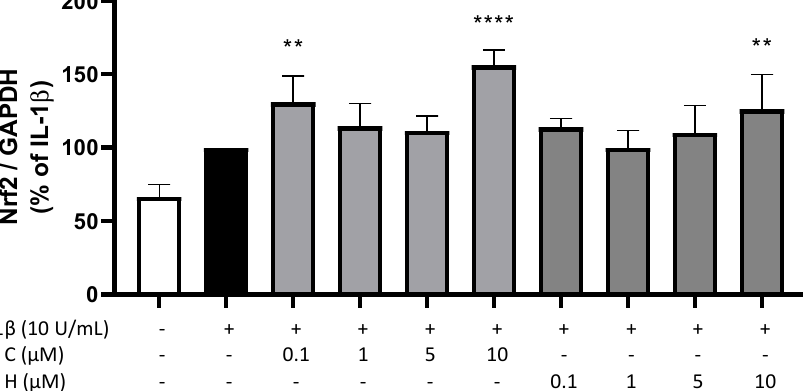
Figure 6. Effects of KIT C (light grey) and KIT H (dark grey) on Nrf-2 expression in IL-1 β -stimulated SK-N-SH cells. SK-cells were stimulated as described in material and methods. After 4 h, RNA was isolated and mRNA levels of Nrf-2 was determined using qPCR. Values are presented as the mean ± SD of at least three independent experiments. Statistical analysis was performed using one-way ANOVA with Dunnett’s post hoc tests with ** p < 0.01 and **** p < 0.0001 compared to IL-1 β .